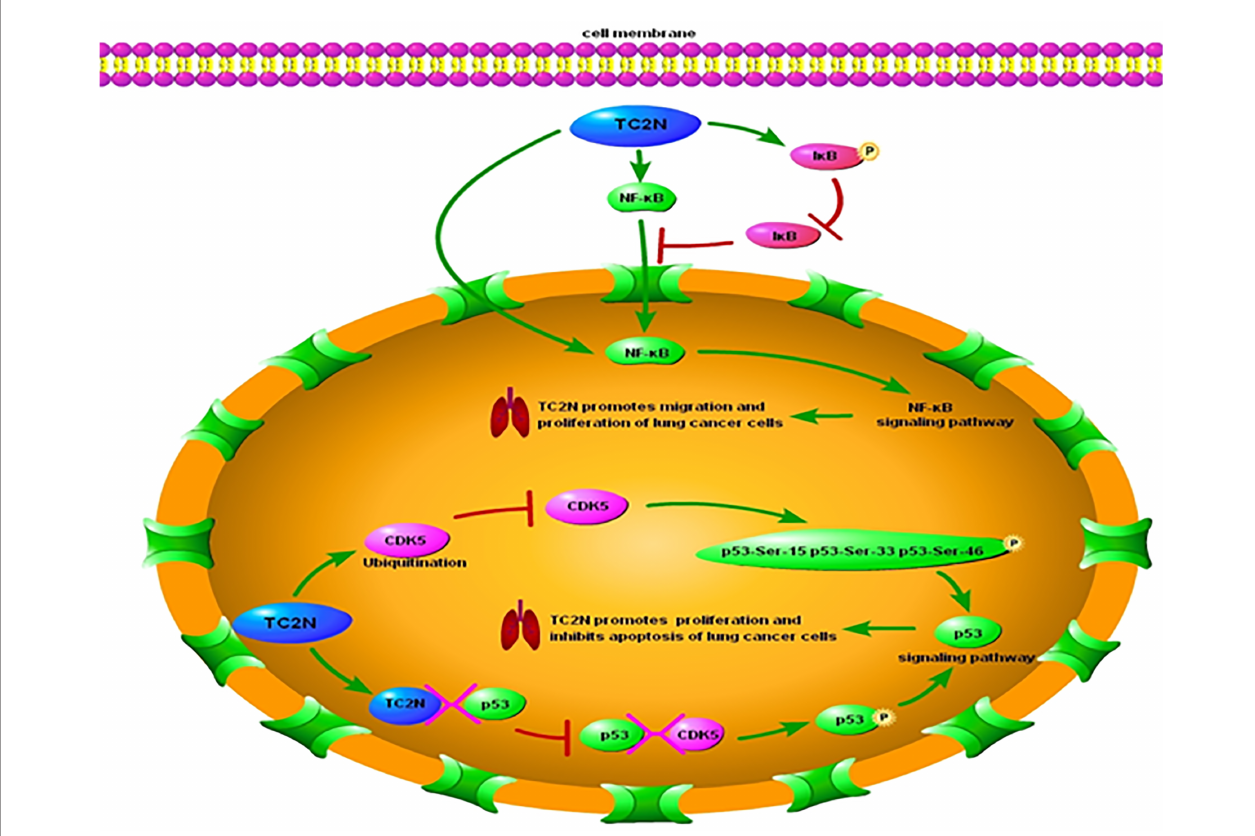
FIGURE 1 | Underlying molecular mechanisms of TC2N in p53 and NF- k B signaling pathways in lung cancer. TC2N, tandem C2 domain nuclear protein; CDK5, cyclin-dependent kinase 5; P53, tumor protein p53; I k B, inhibitor of NF- k B; NF- k B, nuclear factor kappa-light-chain-enhancer of activated B